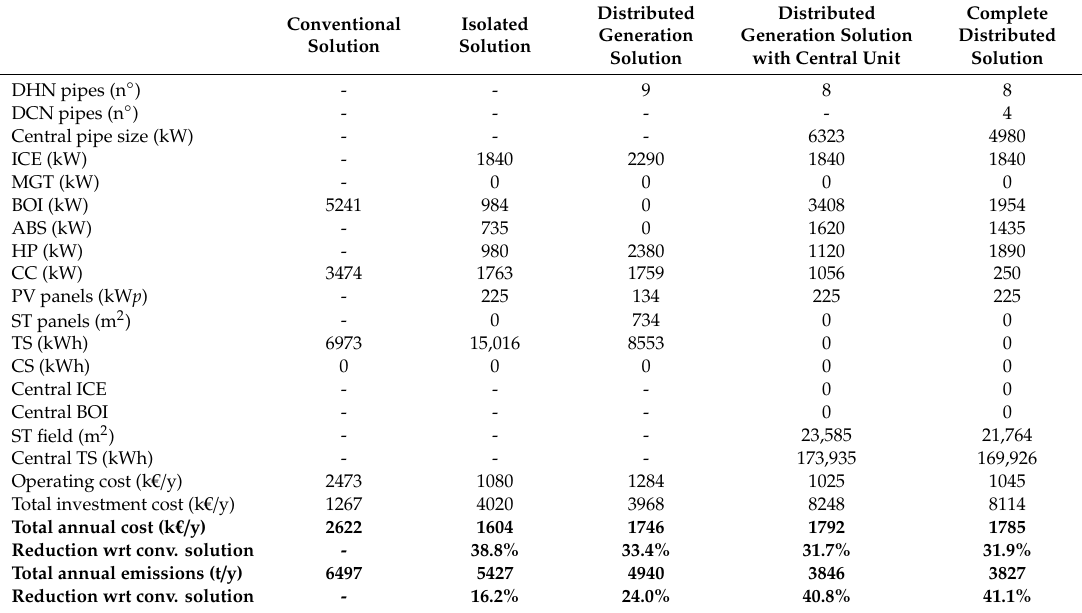
Table 18. Summary of the di ff erent compromise solutions obtained for the di ff erent configurations